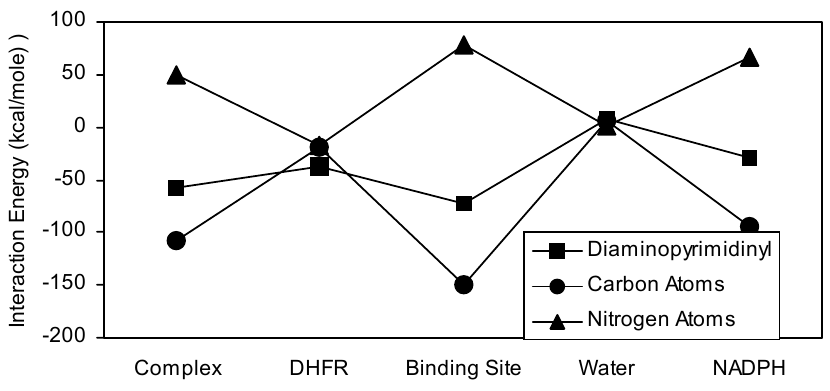
Figure 6. Comparison of interaction energy analysis of the diaminopyrimidinyl region of TMP with its carbon and nitrogen